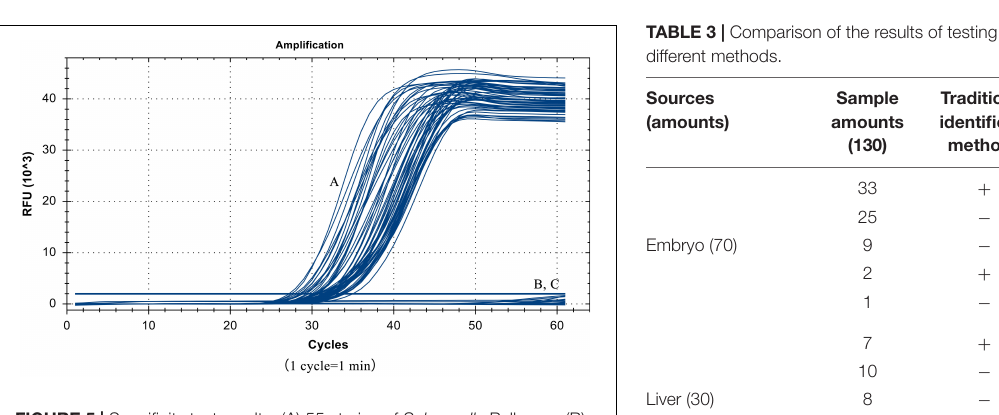
FIGURE 5 | Specificity test results, (A) 55 strains of Salmonella Pullorum. (B) 40 strains of other serotypes of Salmonella and non- Salmonella species. (C) Negative control.